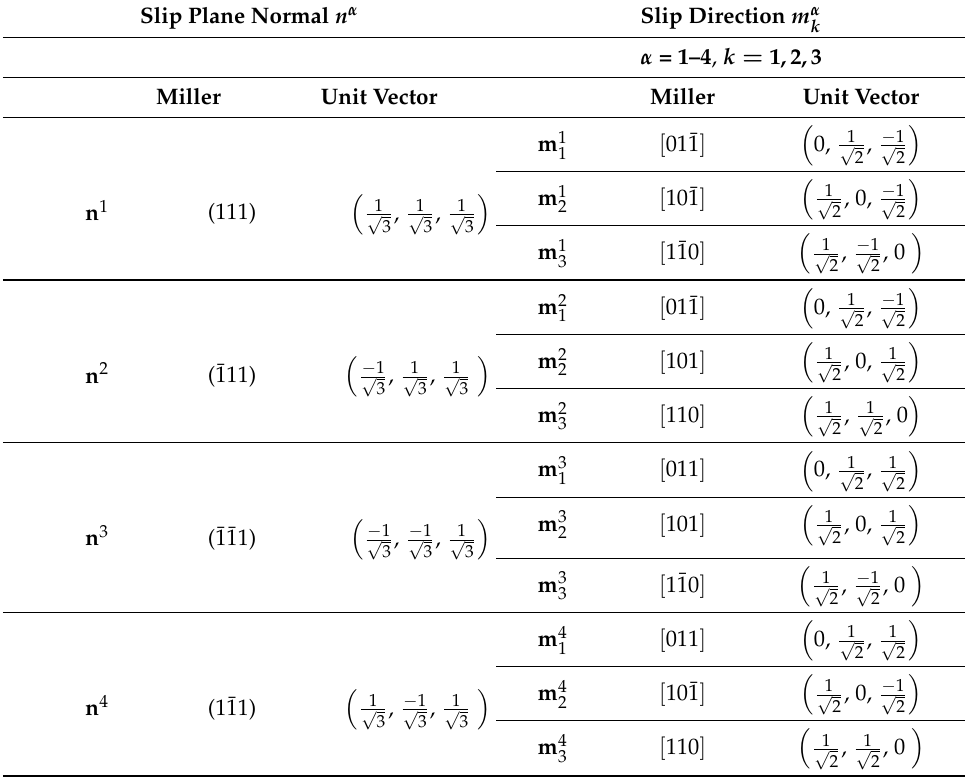
Table A1. Slip systems of FCC